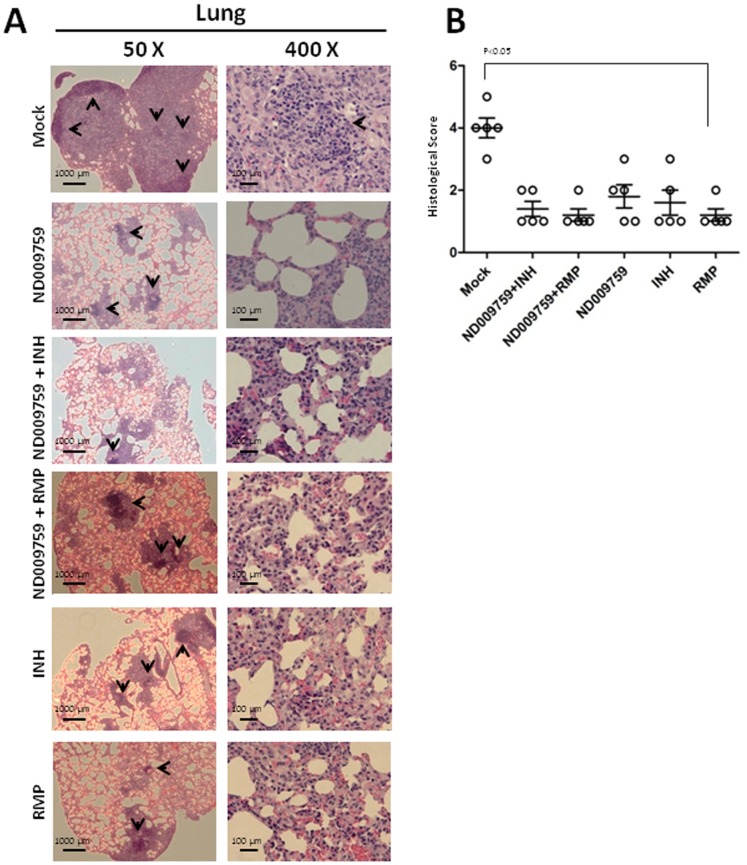
Lung histopathology in drug-treated and untreated infected mice.(A) Images are shown for TB-infected Balb/c mice treated with 80% aqueous propylene glycol (mock), ND-09759 alone, ND-09759 plus INH or RMP, or with INH or RMP alone. The left and right panels show low power (original magnification 50X) and high power (original magnification 400X) of H&E-stained lung sections, respectively. Sections are representative of lung sections from 5 mice per group and from one of two independent experiments. (B) Quantitative scoring of histopathology. Bars represent means ±standard deviation.